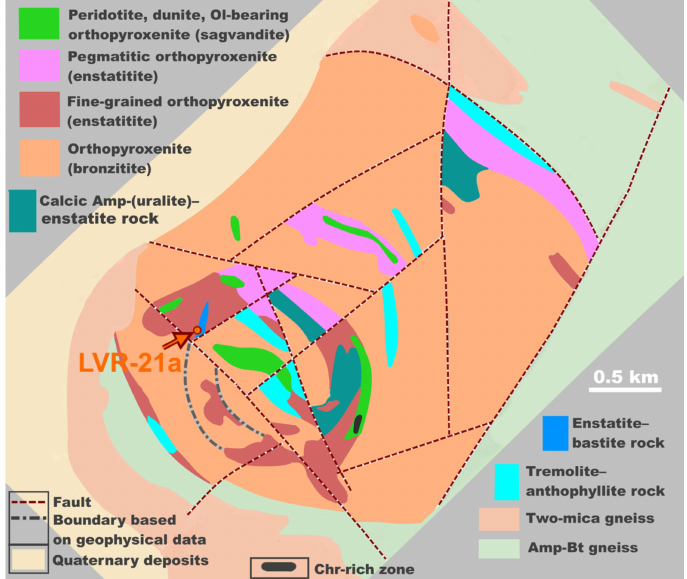
Figure 5. The location of the corona-textured sample (LVR-21a) is shown on a schematic geological map of the Lyavaraka complex, after Spirov